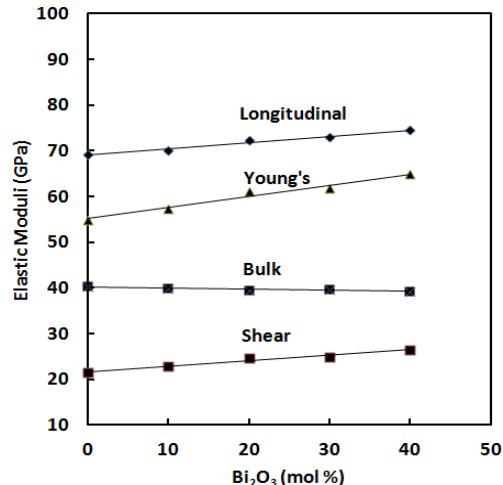
Figure 4. Variation of elastic moduli of ternary (GeO systems with composition. The line is drawn to guide the